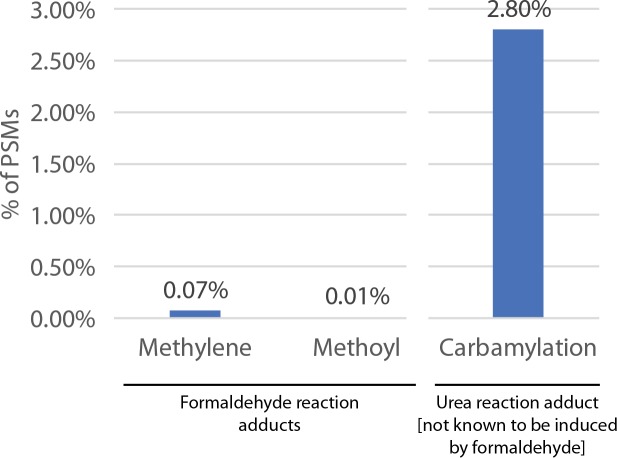
Formaldehyde-induced modifications are generally low.A data-dependent search was performed and identified 0.07% and 0.01% for the major peptide adduct products of formaldehyde, that is methylene and methoyl, respectively.